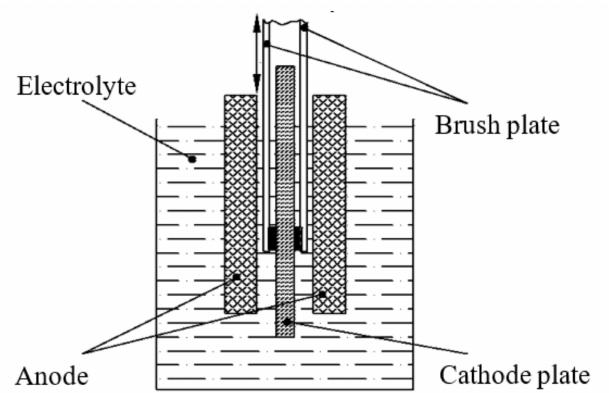
Figure 1. Schematic diagram of the working principle of a nickel powder cleaning